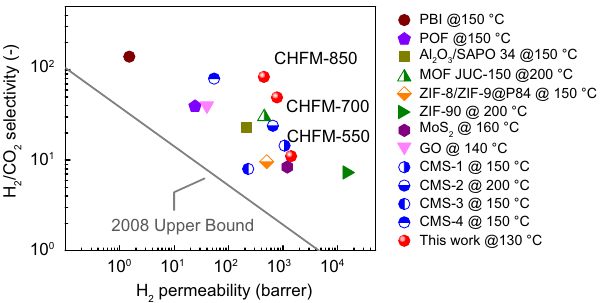
Fig. 4 Comparison of the separation performances of the prepared carbon hollow fi ber membranes (CHFMs) with state-of-the-art H 2 /CO 2 separation membranes. Comparison of gas separation performance of CHFMs developed in this work with state-of-the-art organic and inorganic membrane materials tested at 130 – 200 °C. The solid line is the 2008 Robeson upper bound 44 . The permeabilities of the developed CHFMs were based on a selective layer thickness of 3 μ m. The details are given